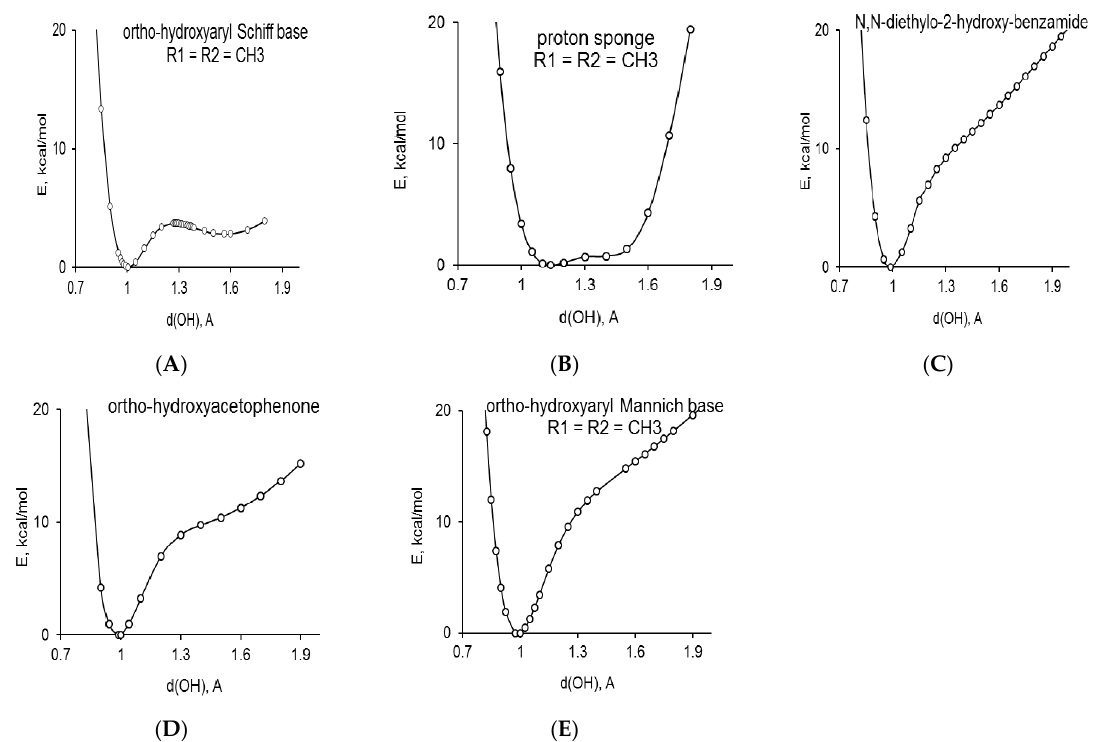
Figure 10. The non-adiabatic potential curves for: ortho -hydroxyaryl Schiff base ( 1 ; R 1 = R 2 = CH 3 , Figure 1) ( A ); 1,8-bis(dimethylamino)-2,7-bis(trimethylsilyl)naphthalene (derivative of proton sponge) ( 4 ; R 1 = R 2 = CH 3 ; Figure 1) ( B ); 2-hydroxy- N , N -diethylbenzamide ( 3 ; R 1 = R 2 = C 2 H 5 ; Figure 1) ( C ); ortho -hydroxyacetophenone ( 2 ; R 1 = CH 3 ; Figure 1) ( D ) and ortho -hydroxyaryl Mannich base ( 5 ; R 1 = R 2 = CH 3 ; Figure 1) ( E ).